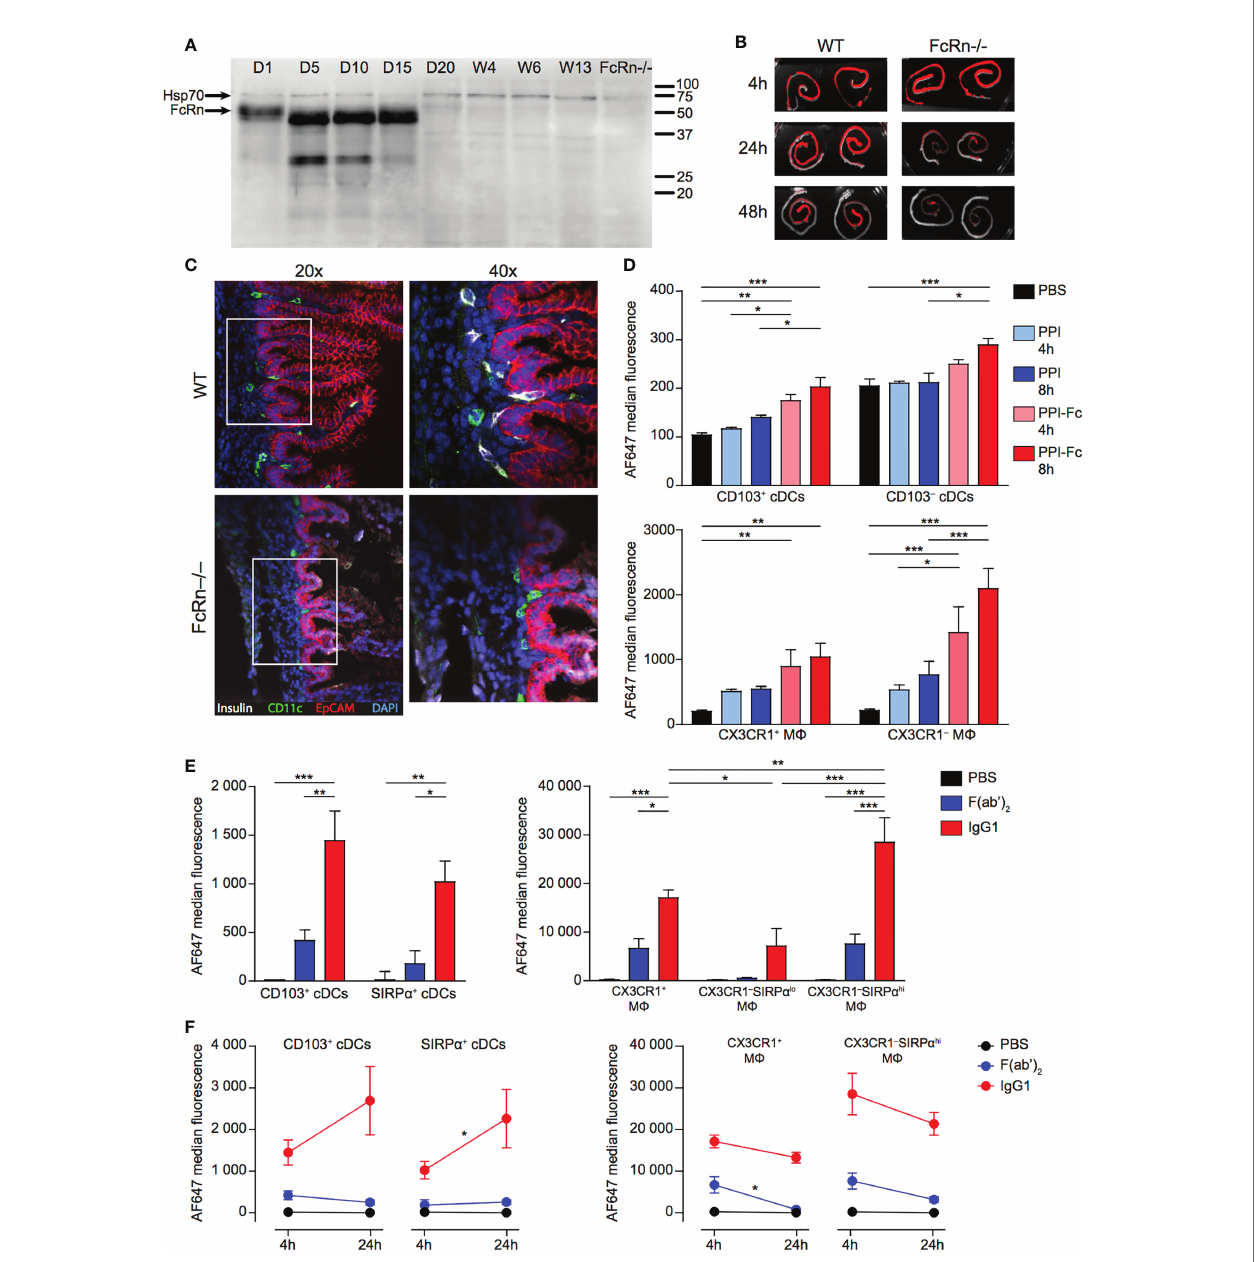
FIGURE 2 | Oral PPI-Fc crosses the gut epithelium in an FcRn-dependent manner and is taken up by LP DCs and macrophages. (A) Age-dependent FcRn expression in the gut epithelium. Intestinal epithelial cells were isolated from the whole digestive tract of 1-day-old to 13-week-old G9C8.NOD mice and 1-day-old FcRn -/- .B6 mice and probed for FcRn, and Hsp70 as loading control. (B) One-day-old wild-type G9C8.NOD (WT) or FcRn -/- .B6 mice were force-fed with 50 µg of AF680-labeled PPI-Fc. Ex-vivo imaging of the intestines of WT and FcRn -/- mice (n=2/each) 4, 24 or 48 h after PPI-Fc force-feeding. (C) Confocal images of the same intestines recovered from WT and FcRn -/- .B6 mice at 24 h (20X and 40X magni fi cations). Sections were stained for insulin (white), CD11c (green) and EpCAM (red), with nuclei counterstained with DAPI (blue). (D) Five-day-old G9C8.NOD mice were force-fed with 50 µg AF647-labeled PPI-Fc (red bars), PPI (blue), or PBS (black). LP cells were isolated 4 or 8 h after gavage, and protein uptake (AF647 median fl uorescence) was analyzed in CD103 + and CD103 ‒ cDCs and CX3CR1 + CD11b ‒ and CX3CR1 ‒ CD11b + macrophages (M F ). (E) Five-day-old G9C8.NOD mice were force-fed with 50 µg AF647-labeled IgG1 (red), F(ab ’ ) 2 (blue), or PBS (black). Four hours later, protein uptake was analyzed in the LP for the indicated APC subsets: CD103 + and SIRP a + cDCs (left) and CX3XR1 + , CX3CR1 ‒ SIRP a lo and CX3CR1 ‒ SIRP a hi macrophages (M F , right). (F) Comparison of the AF647 median fl uorescence at 4 and 24 h in the same APC subsets. Results in (D – F) are expressed as mean ± SEM from 3 mice per group. * P ≤ 0.03, ** P ≤ 0.007, *** P ≤ 0.0002 by 2-way